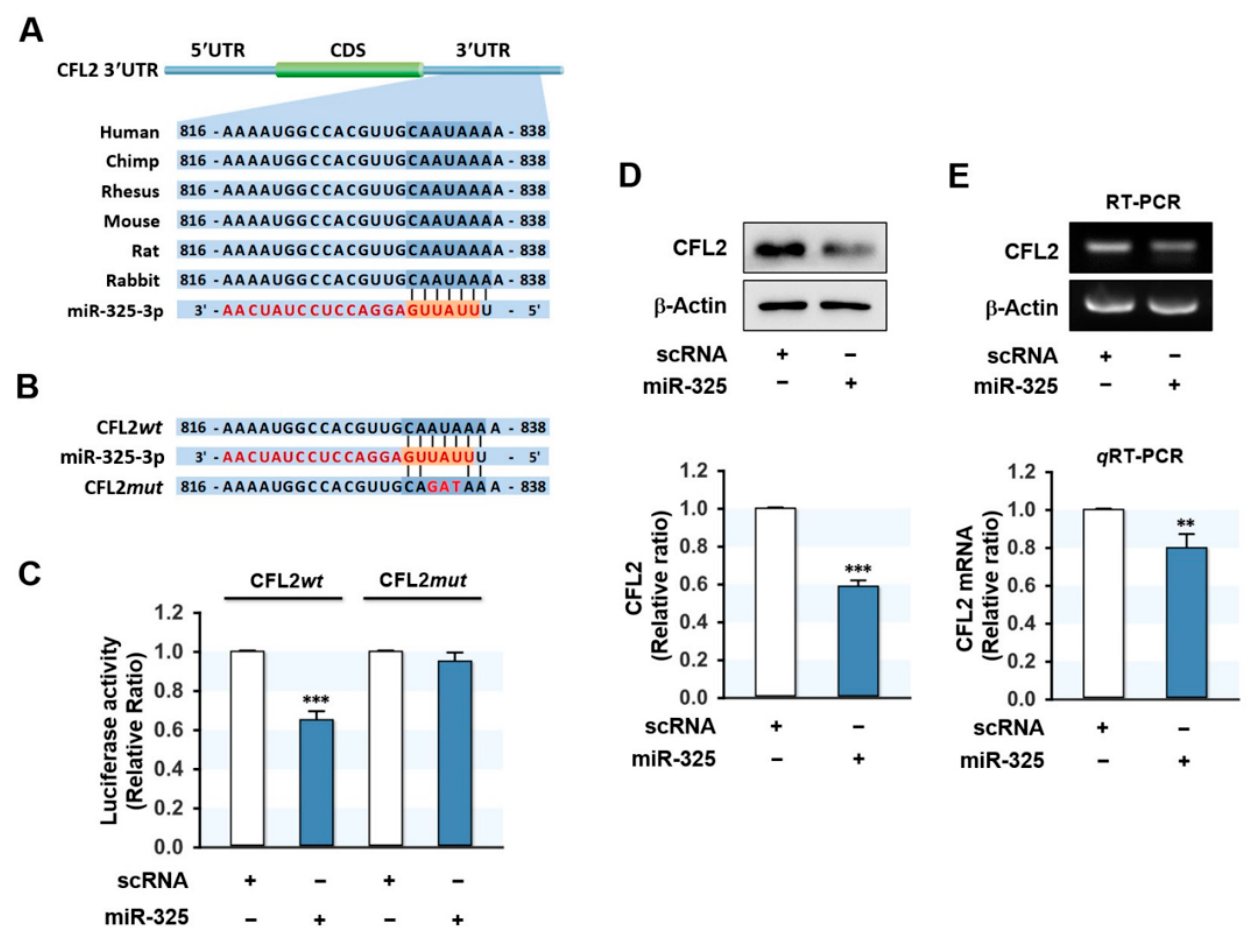
Figure 2. MiR-325-3p regulated CFL2 expression by binding to the 3 ′ UTR of CFL2 . ( A ) Putative binding sites of miR-325-3p on the 3 ′ UTR fragments of CFL2 mRNA. ( B ) Sequence alignment of miR-325-3p binding site with wild-type (CFL2 wt ) or mutant (CFL2 mut ) 3 ′ UTR of CFL2 . ( C ) MiR-325-3p mimic or scrambled control RNA (scRNA) were co-transfected with a dual-luciferase reporter construct containing CFL2 wt or CFL2 mut in C2C12 cells, and relative luciferase activity was measured 24 h after transfection. ( D ) CFL2 protein levels were analyzed 24 h after transfection with 200 nM of scRNA control or miR-325-3p mimic by immunoblotting. ( E ) The mRNA expressions were determined by RT-PCR (upper panel) and q RT-PCR (lower panel). Immunoblot and q RT-PCR results are shown as relative ratios versus scRNA control. All results are presented as the means ± SEMs ( n > 3), and levels of significance are presented as **, p < 0.01; ***, p < 0.001 vs. scRNA controls.